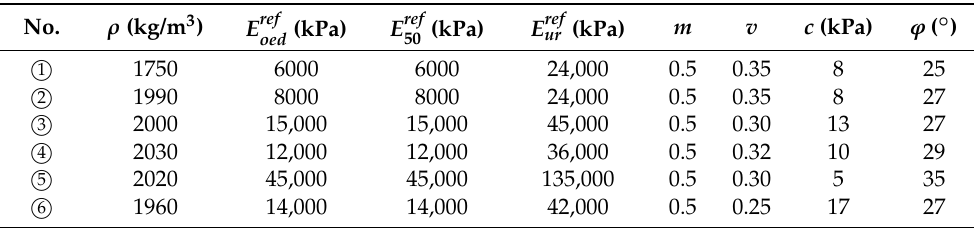
Table 1. Physical and mechanical parameters of soil.